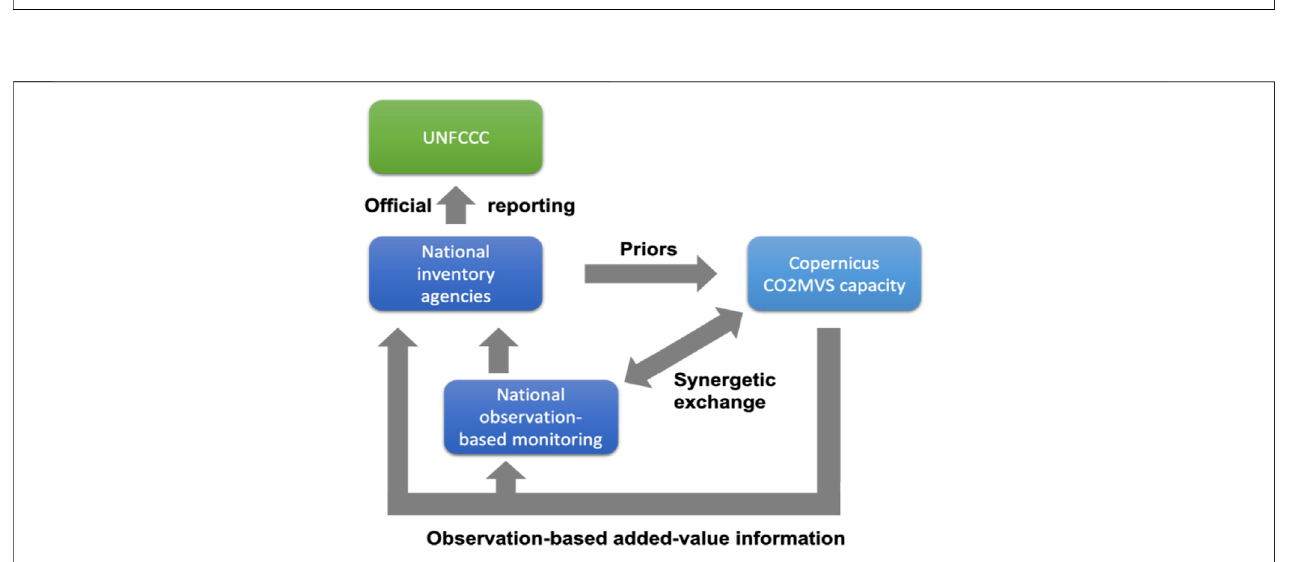
FIGURE8| SchematicoftheanthropogenicCO2emissionsMonitoringandVeri fi cationSupportcapacity(CO2MVS)asdevelopedintheCHEprojectandadopted by the CO2 Monitoring Task Force. The foreseen service provision elements are depicted by the coloured boxes, while the required continuous development of the operational services is depicted by the white boxes.